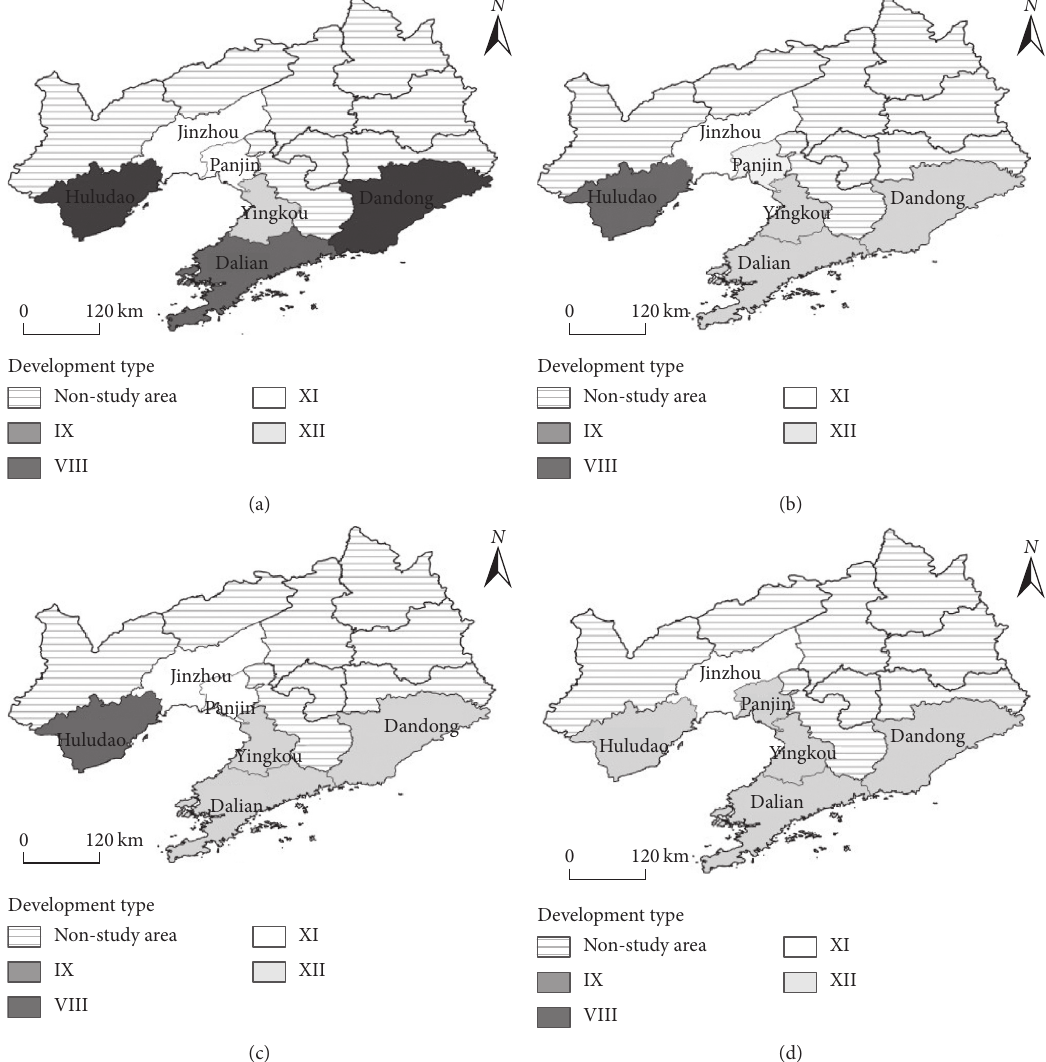
Figure 6: Spatial variation of relative development degree of six coastal cities in Liaoning Province. (a) 2004. (b) 2008. (c) 2012. (d)